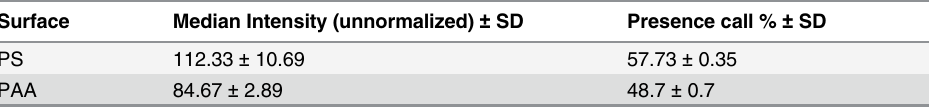
Table 1. Microarray probe